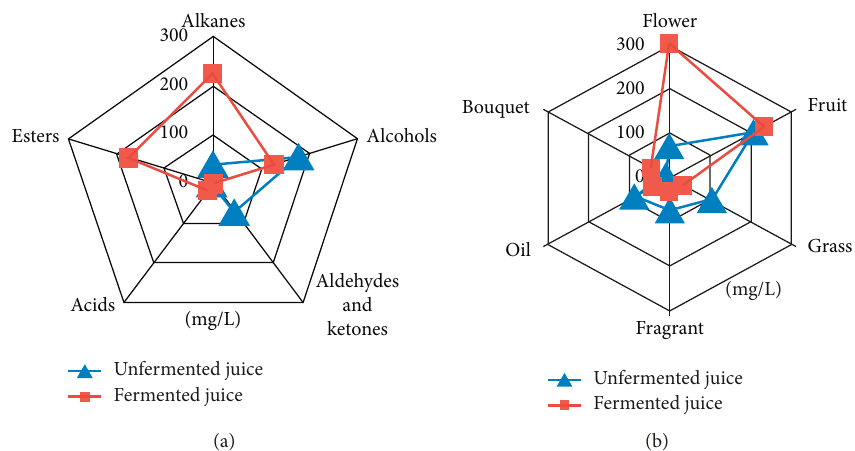
Figure 2: Volatile structure (a) and aroma style (b) distribution of the unfermented and fermented juice.